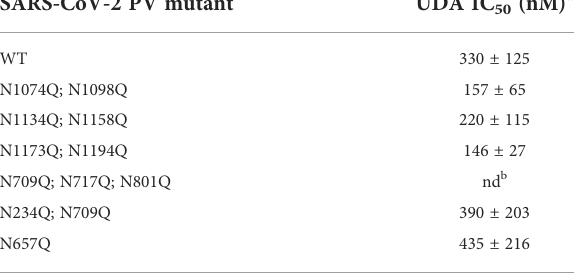
TABLE 2 Antiviral activity of UDA against glycosylation mutants of pseudotyped SARS-CoV-2. SARS-CoV-2 PV